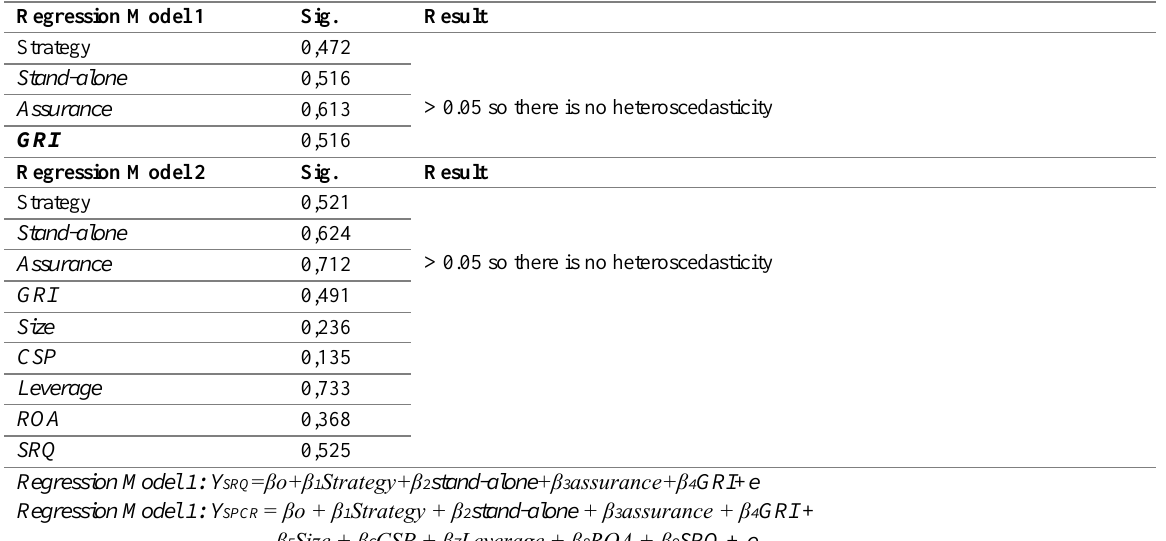
Table 7 : Heteroscedasticity test results